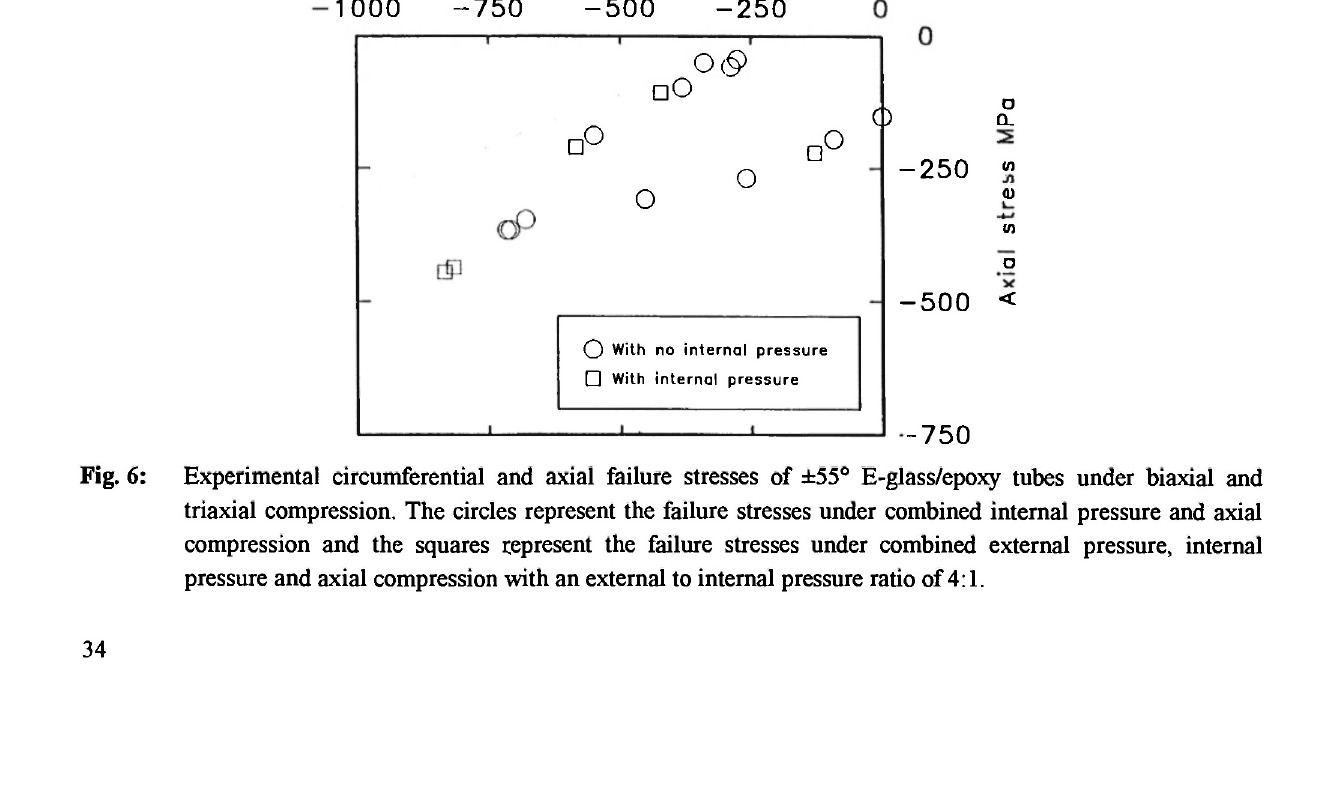
;b) For manual control testing Fig. 5: Schematic of the control circuit used for testing tubes (a) for auto feed back system (b) for manual control.